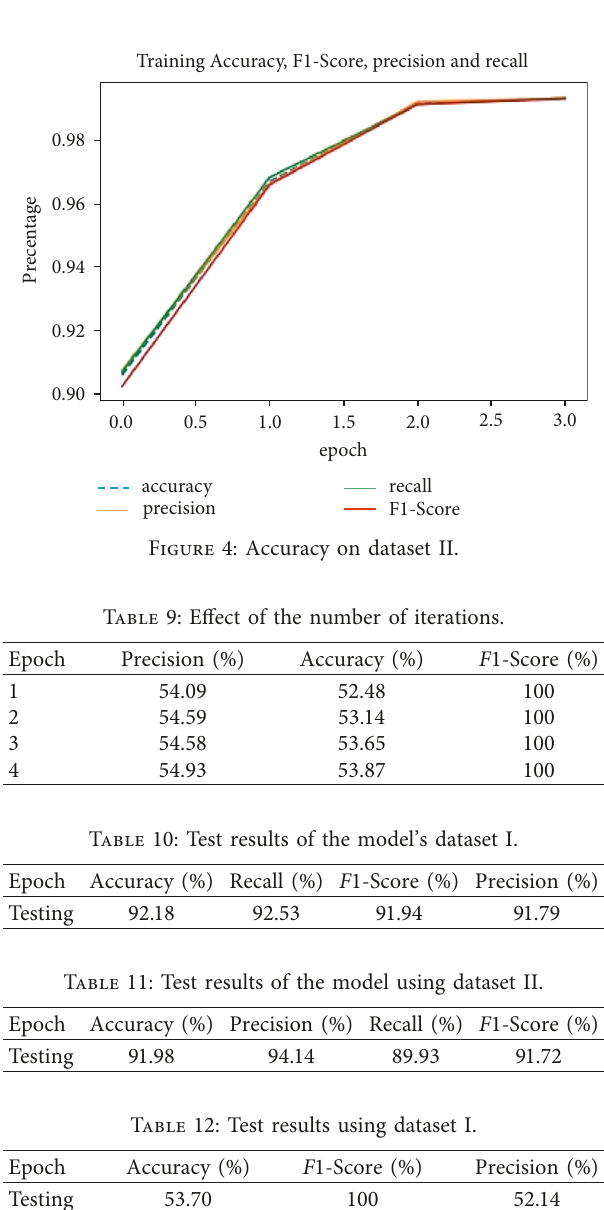
Figure 3: Accuracy on dataset I.